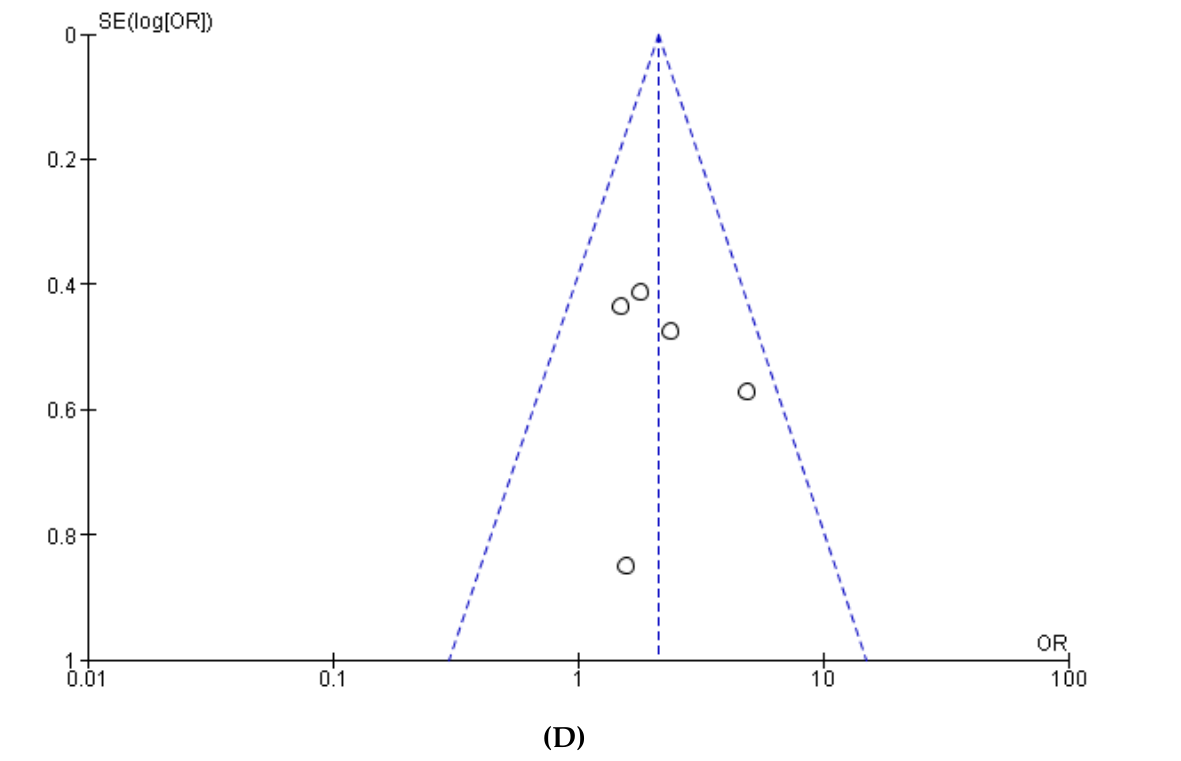
Figure A2. ( A ) Covid+ pregnant women vs. Covid- pregnant women, outcome: 1.1 Vitamin D serum Figure B1. ( A ) Covid+ pregnant women vs Covid- pregnant women, outcome: 1.1 Vitamin D se- levels. Funnel plot. ( B ) Funnel plot of comparison: 2 BMI >= 30 vs. BMI < 30, outcome: Disease severity. rum levels. Funnel plot. ( B ) Funnel plot of comparison: 2 BMI >= 30 VS BMI < 30, outcome: Disease ( C ) Funnel plot of comparison: 2 BMI >= 30 vs. BMI < 30, outcome: Maternal death. ( D ) Funnel plot of severity. ( C ) Funnel plot of comparison: 2 BMI >= 30 VS BMI < 30, outcome: Maternal death. ( D ) comparison: 2 BMI >= 30 vs. BMI < 30, outcome: Hospital Funnel plot of comparison: 2 BMI >= 30 VS BMI < 30, outcome: Hospital admission